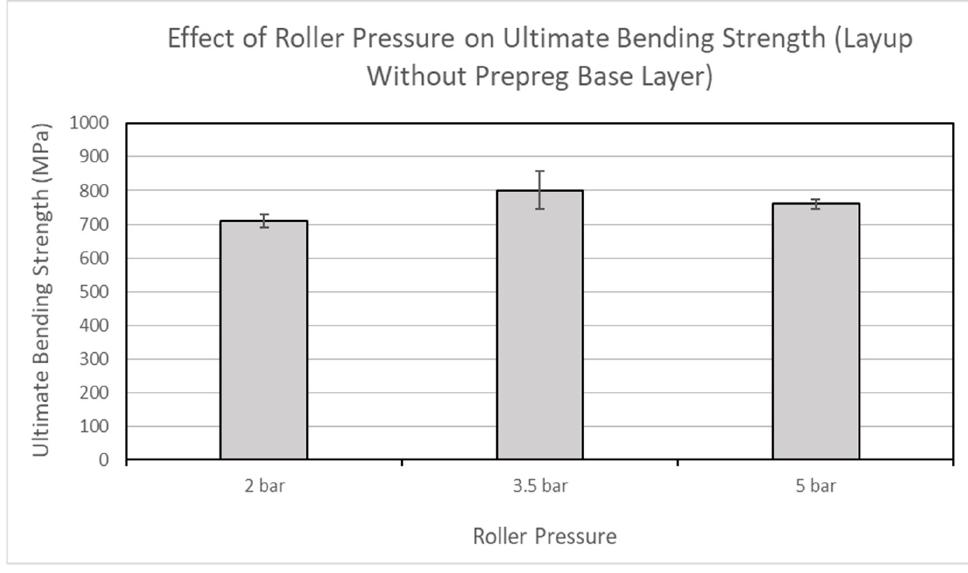
Figure 20. Effect of roller pressure and base layer on ultimate bending strength for layups without prepreg base layer.